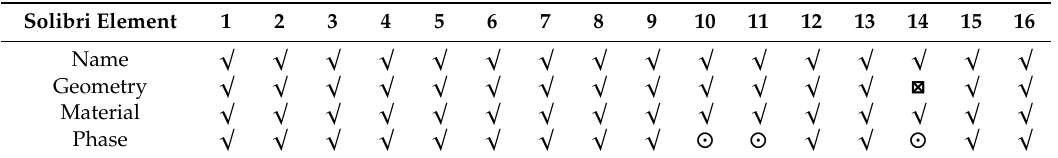
Table 5. Results of tests of BIM interoperability through the IFC standard, obtained by importing the sample IFC model into Graphisoft Solibri Model Checker (